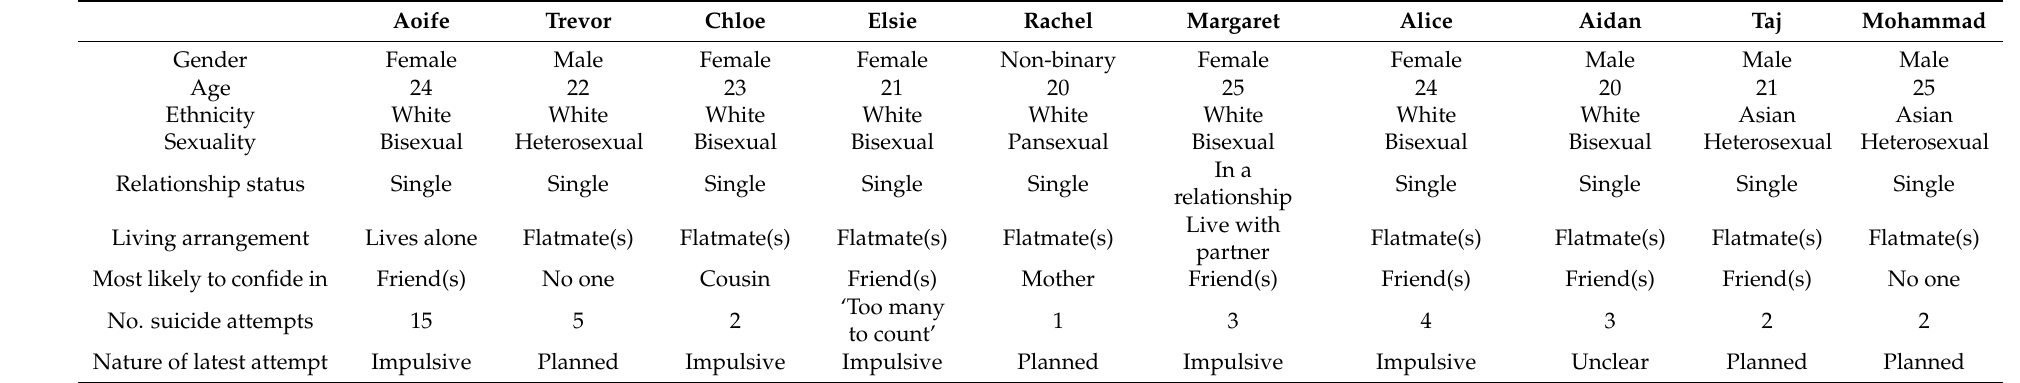
Table 1. Participant